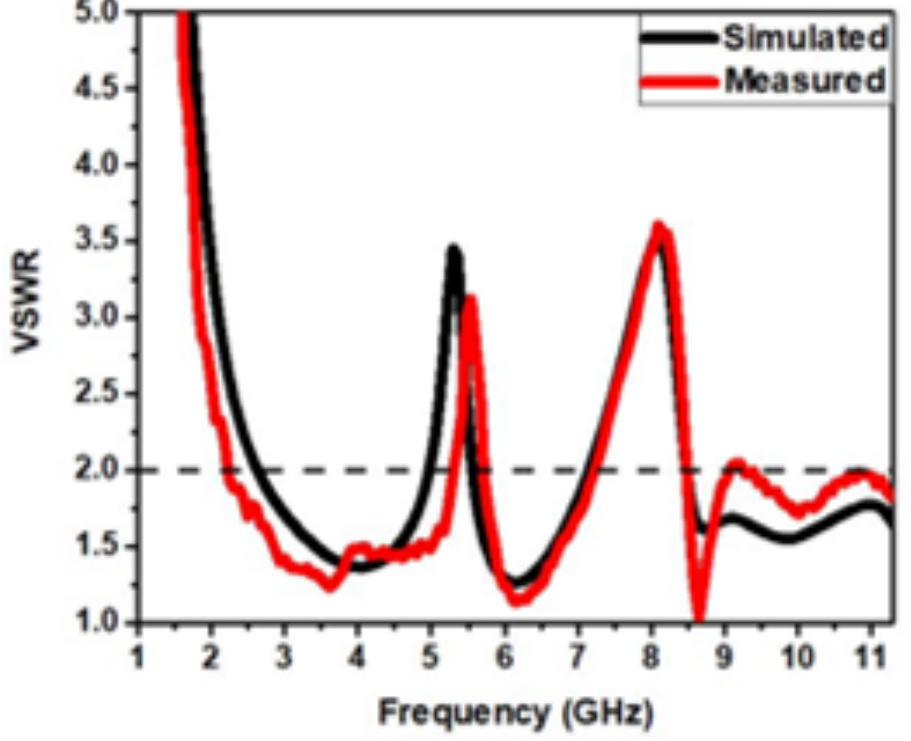
Figure 21. VSWR of UWB notch antenna, simulated and measured.